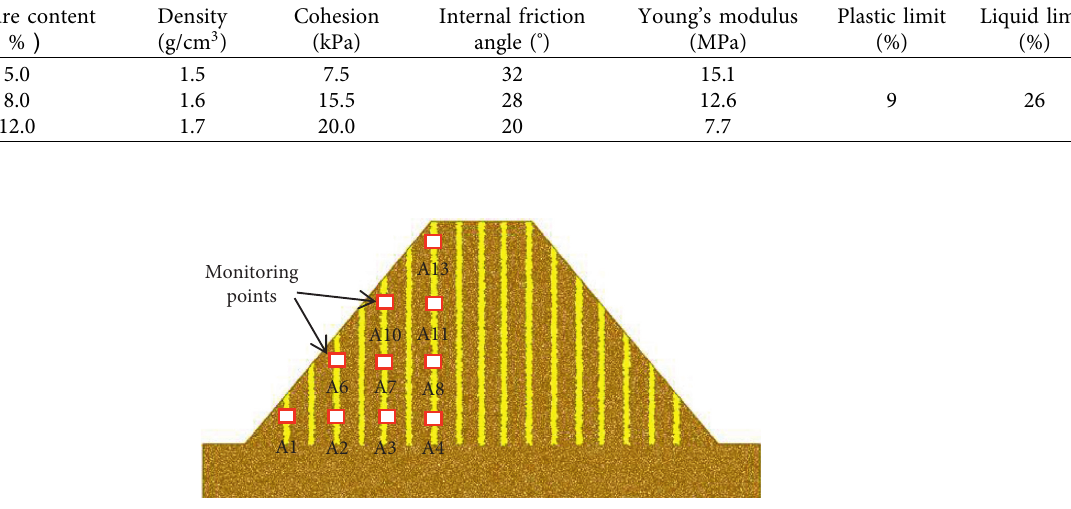
Figure 4: Geometrical model in numerical